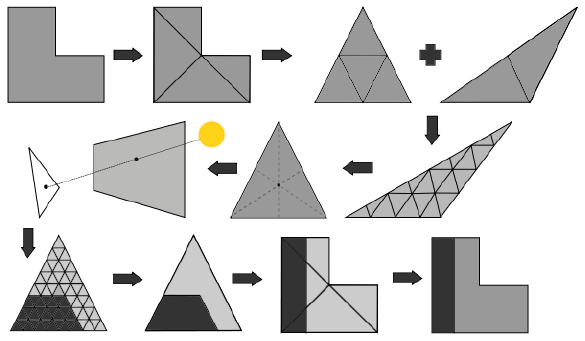
Figure 1. Workflow of shadow detection (Alam et al, 2011)